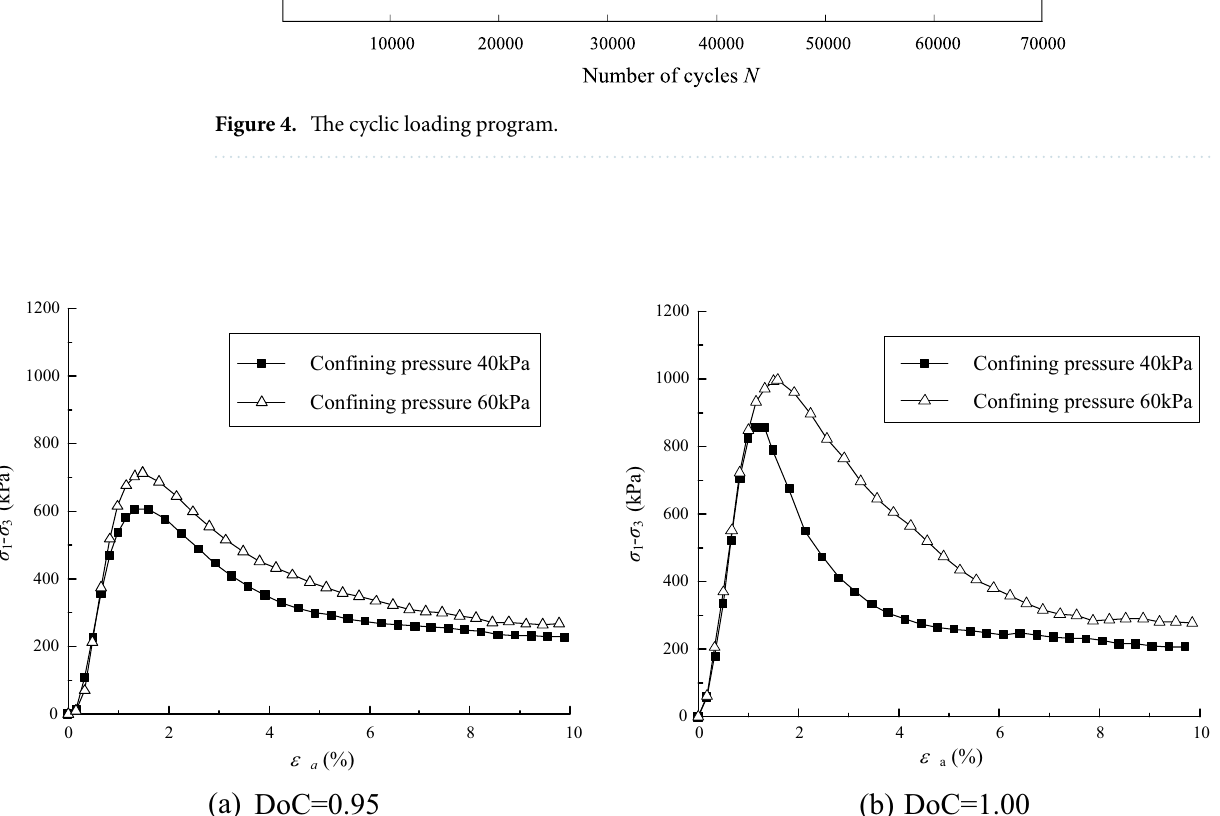
Figure 5. The relationship between deviatoric stress and axial strain for samples with DoC of (1) 0.95 and (2)